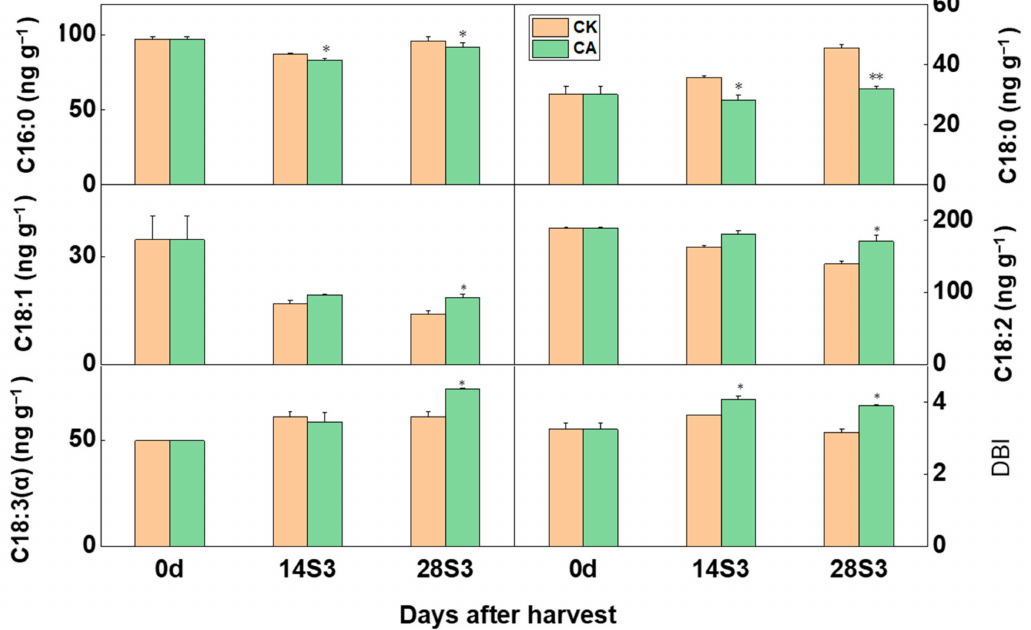
Figure 6. Determination of the fatty acid under CA treatment during the Shelf-life after cold storage. Data are expressed as the means ± standard error of three biological replicates and the * indicated the statistical significance of the two samples with the unpaired Student’s t -test (* p < 0.05, ** p < 0.01).